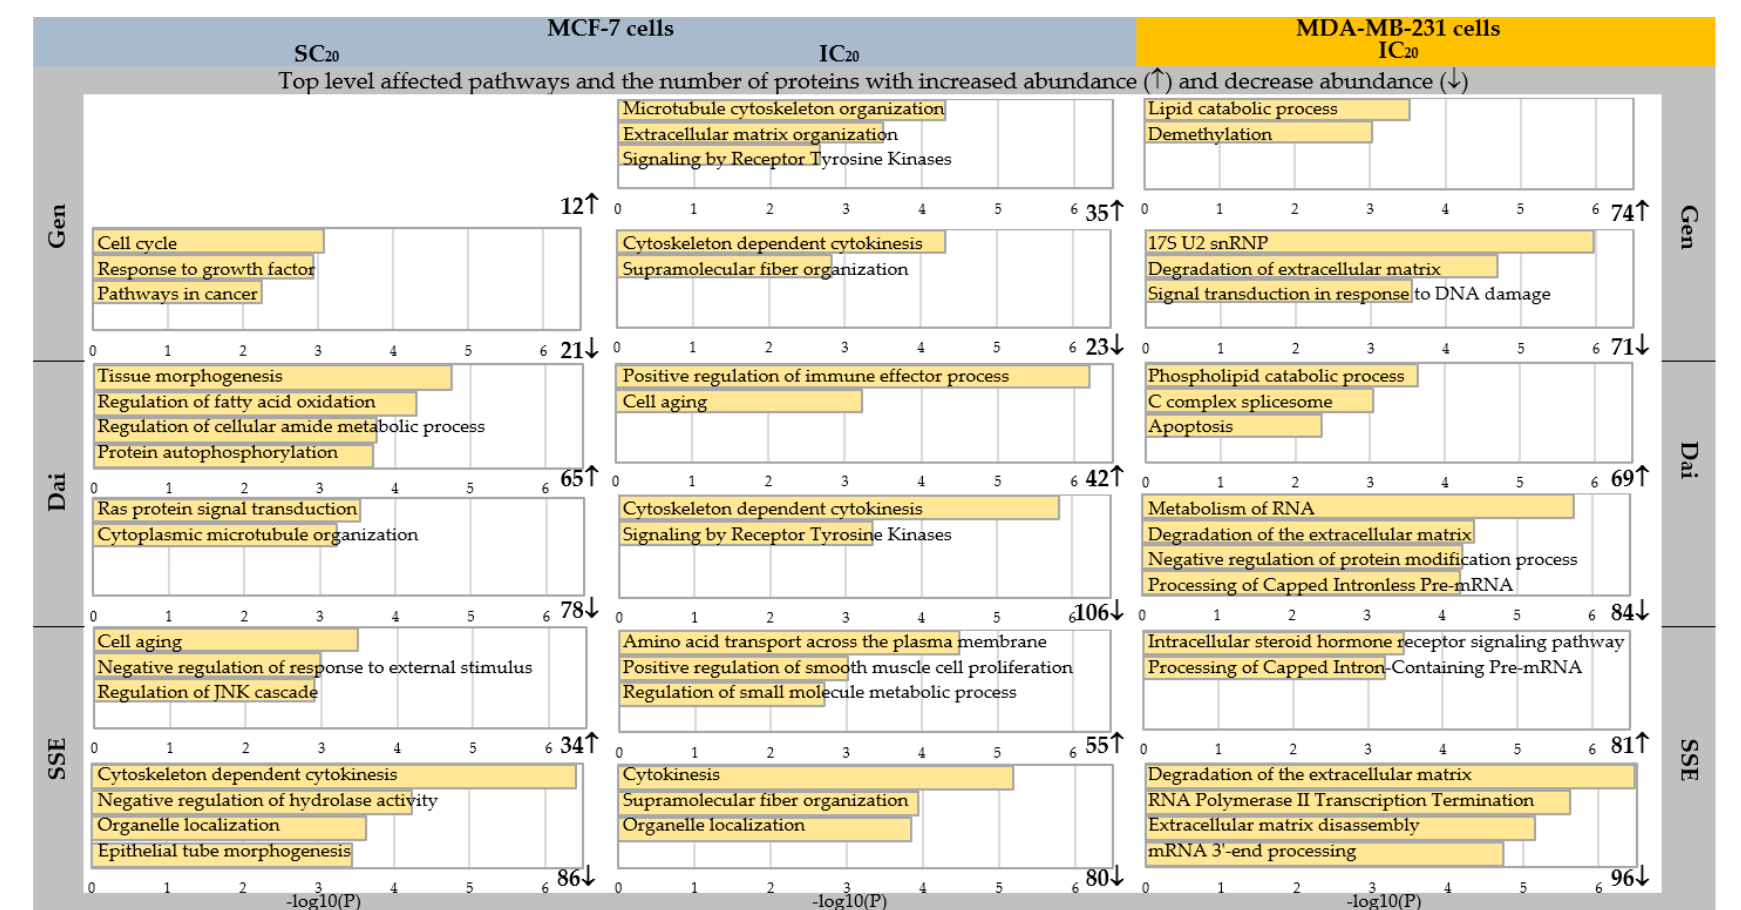
Figure 3. Comparative view on affected pathways as indicated by enrichment pathway analysis and the number of proteins with significantly increased ( ↑ ) or reduced ( ↓ ) abundance identified in MCF-7 and MDA-MB-231 breast cancer cells following exposure to Gen, Dai, and SSE at stimulatory (SC 20 ) and inhibitory (IC 20 ) concentrations, respectively. Table 2. Comprehensive view of the most altered molecular pathways, as indicated by the enrichment pathway analysis, along with the identified associated proteins following exposure of MCF-7 and MDA-MB-231 breast cancer cells to Gen, Dai and SSE.